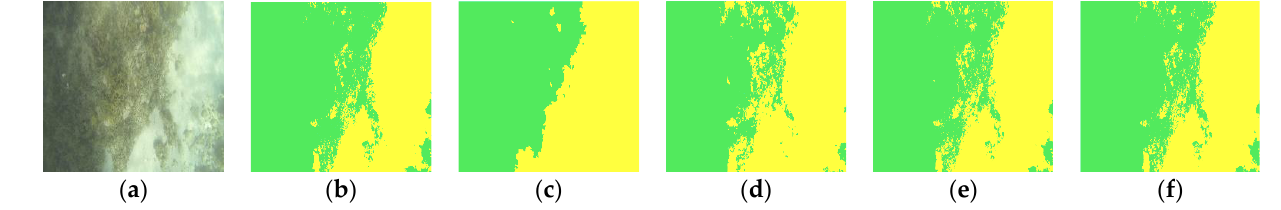
Figure 5. Validation tests of the proposed segmentation algorithms using highly illuminated and low contrast algae image (1) from Figure 3 as example of two categories: ( a ) original image; ( b ) ground truth image; ( c ) FF result; ( d ) FR result; ( e ) OS result; ( f ) KM result. Green: algae and yellow: sediments.